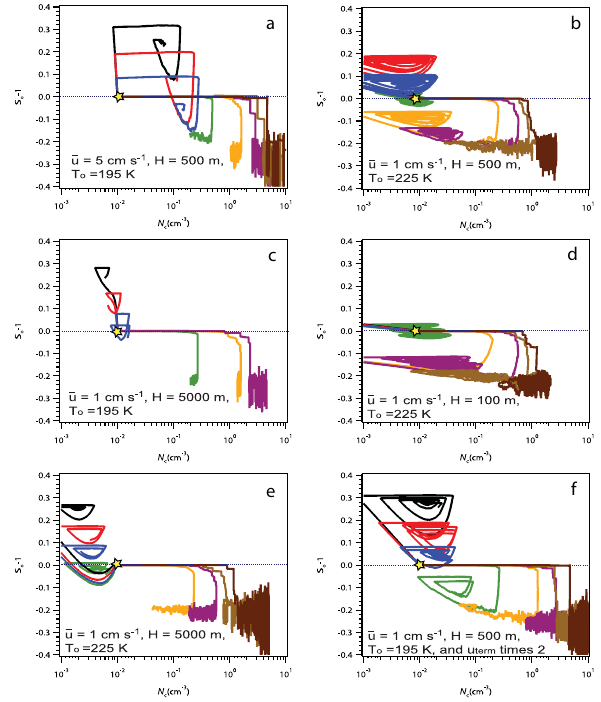
initial layer temperature, T o , cloud thickness, H , and mean ice crys- tal terminal velocity, u term . The yellow star in each plot indicates initial conditions. The integration time was 40h in for ¯ u = 1cms − 1 and 15h for ¯ u = 5cms − 1